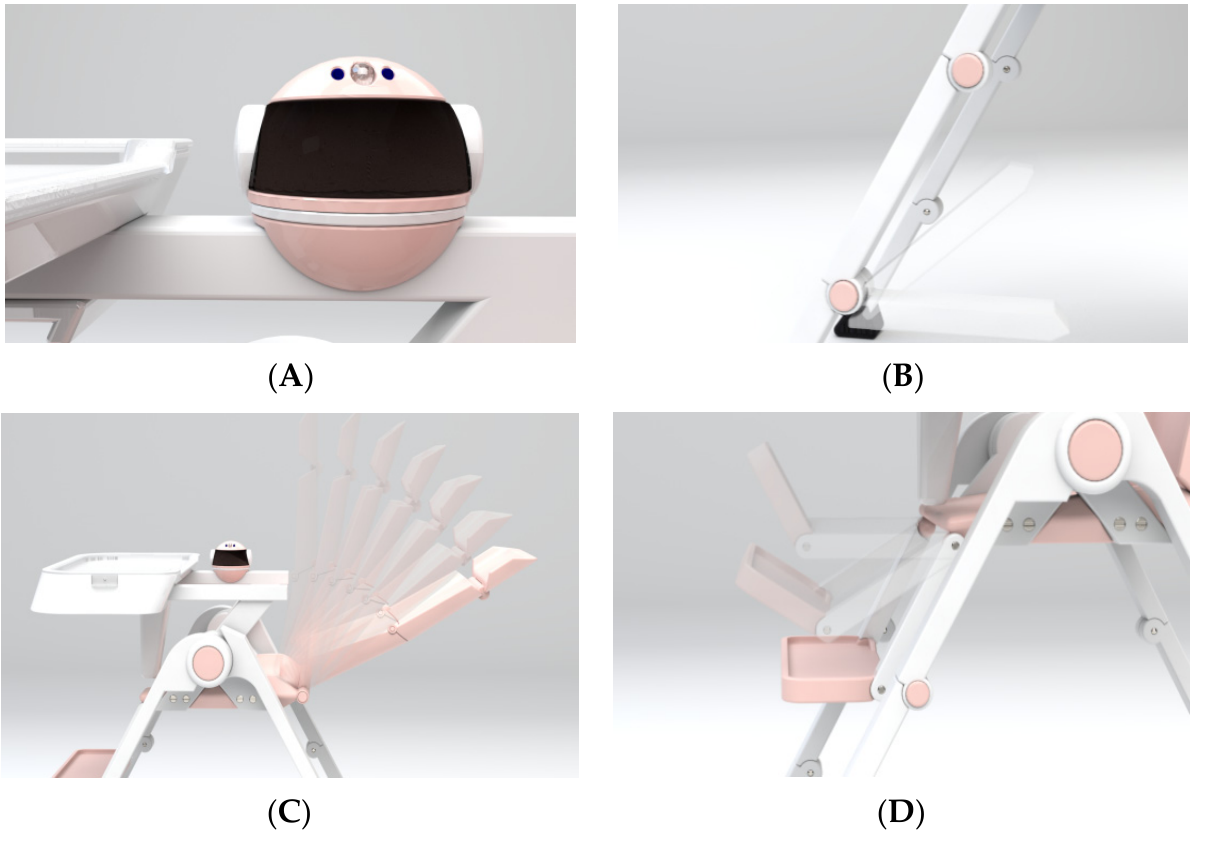
Figure 2. ( A ). Artificial intelligence hardware. ( B ). Three heights of support legs. ( C ). Rotation adjustment on backrest. ( D ). Flexible rotation of the footrest.